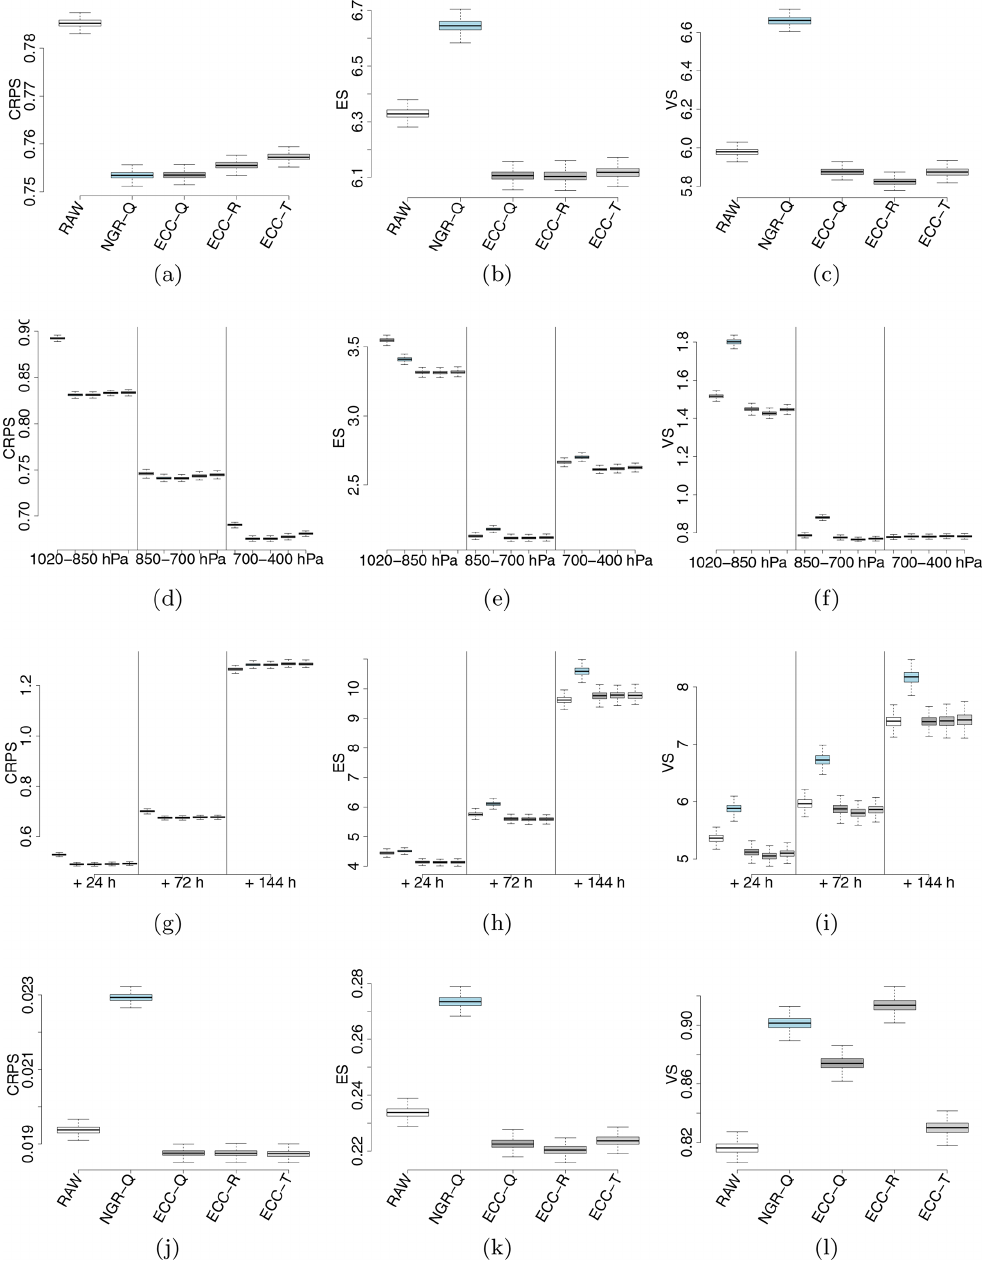
Figure 12. Bootstrapped continuous ranked probability score (CRPS, first column), energy score (ES, second column) and variogram score (VS, third column) for the raw ensemble (RAW), the quantile sample of the NGR-postprocessed (NGRVC-Q), the quantile sample of ECC (ECC-Q), the random sample of ECC (ECC-R) and the transformed sample of ECC (ECC-T). The first row shows results for all pressure ranges and lead times combined, the second row stratified by three pressure ranges but over all lead times, and the third row by three lead times. Note that the range of the scores changes between rows. The bottom row shows the scores for the temperature gradient d T/ d p . Lower values are better for all three